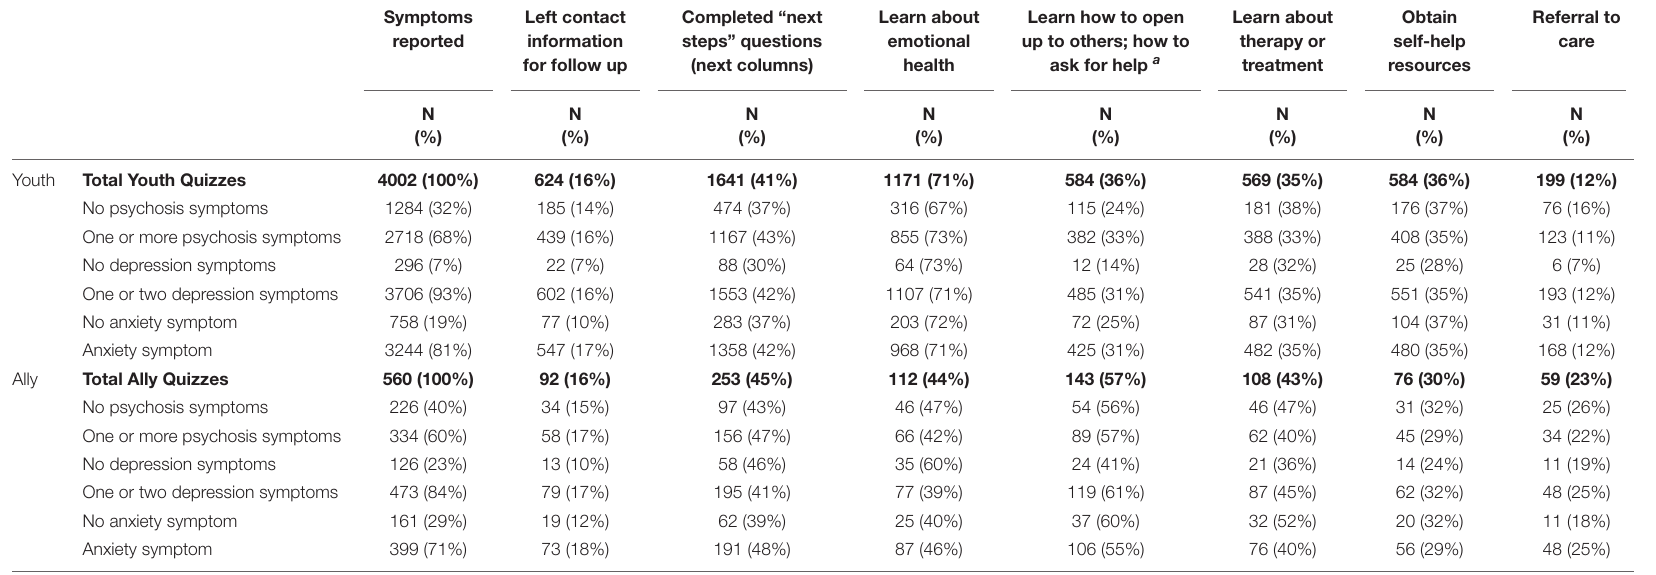
TABLE 3 | User preferences grouped by diagnostic risk